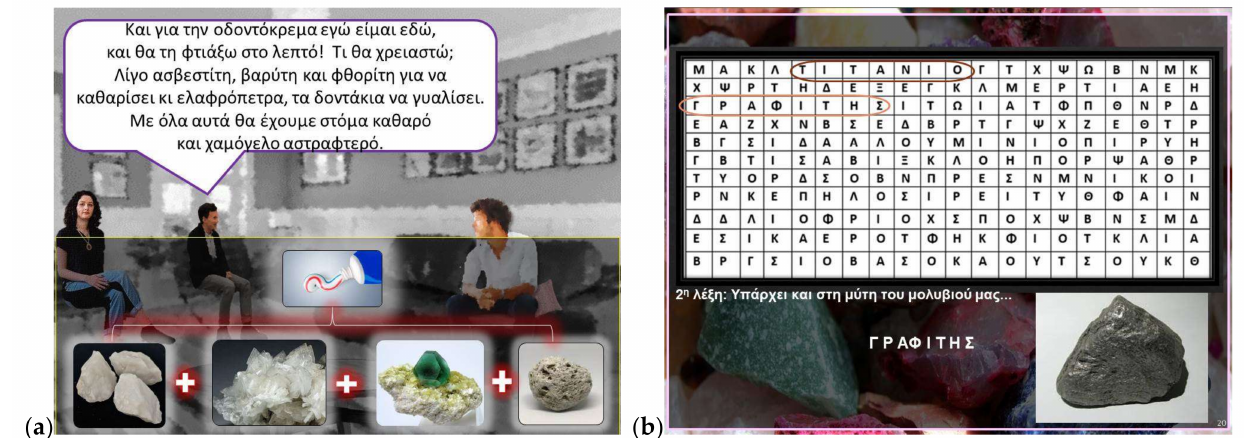
Figure 1. Snapshots from: ( a ) the first part story/roleplay game “Geology in our lives”; ( b ) the recognition/identification game “Geology in